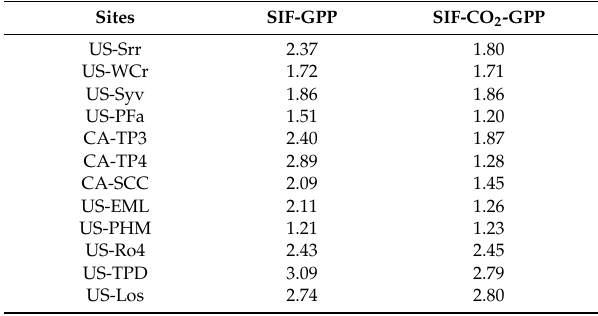
Table 4. Root-mean-square error (RMSE) of SIF-GPP and SIF-CO 2 -GPP model. The unit is g Cm − 2 day − 1